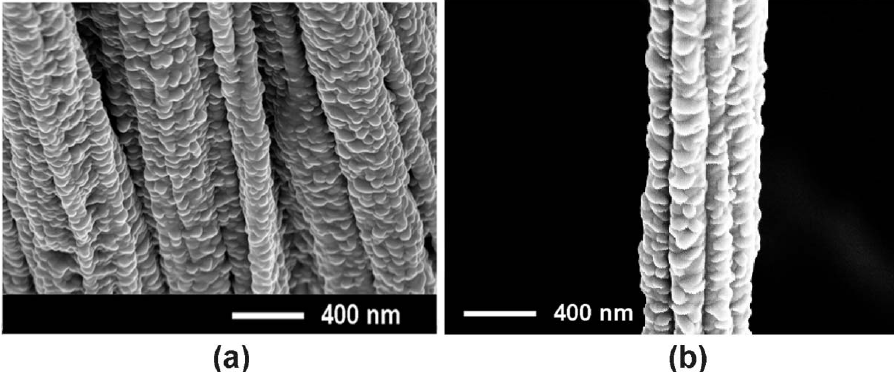
Figure 3. ( a ) SEM image of a GaAs nanowire array coated with a TiO 2 layer; ( b ) SEM image of a GaAs nanowire bundle coated with a ZnO layer.